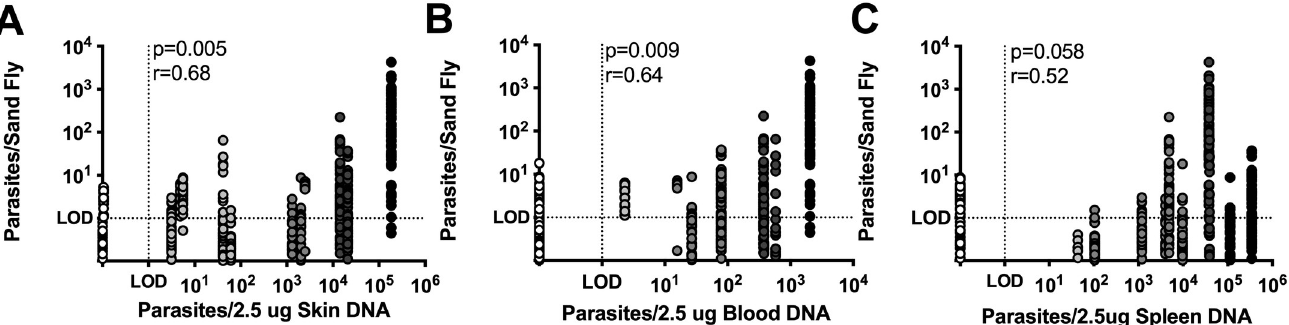
Fig 4. Skin parasite burden is best correlate of parasite transmission to sand flies. Correlation between calculated parasite uptake by individual sand flies after xenodiagnosis and paired (A) average skin parasite burden (n = 16), (B) blood parasite burden (n = 16), (C) or splenic parasite burden (n = 14). Skin parasite burden was averaged between the two biopsies collected from ipsilateral feeding sites. Spearman correlation p-value and correlation coefficient (r) are shown.